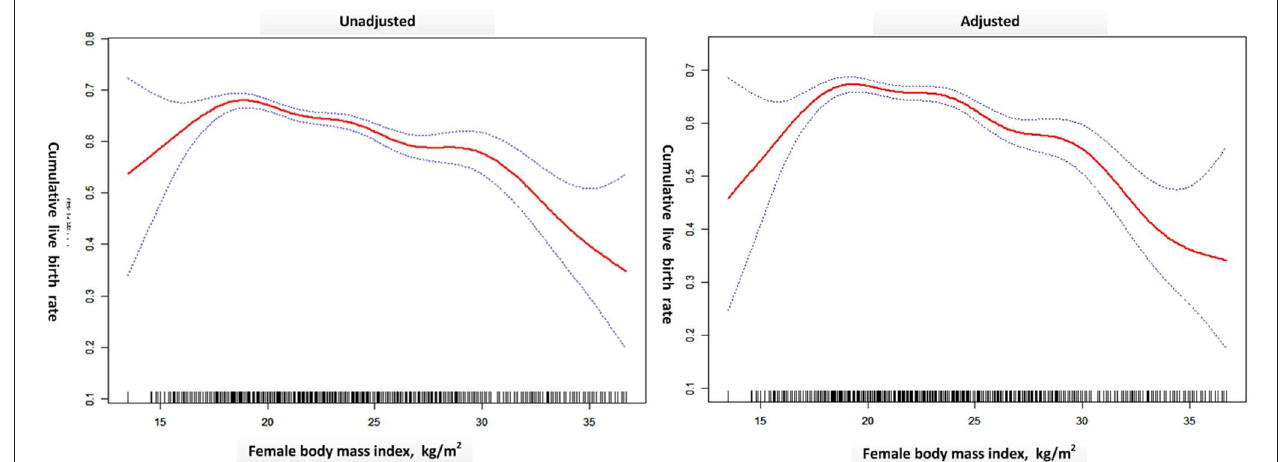
FIGURE 2 | A generalized additive model was built where the outcome was the CLBR and the explanatory variable was BMI (red dots). The blue dotted lines are the 95% confidence intervals. The right model was adjusted for treatment year, patient’s age, AFC, basal FSH, smoking habits, type of infertility, length of infertility, gravidity, parity, main etiology, OS protocol, Gn total dose, Gn type, and FSH start dose. Created by EmpowerStats (www.empowerstats.com) and R.